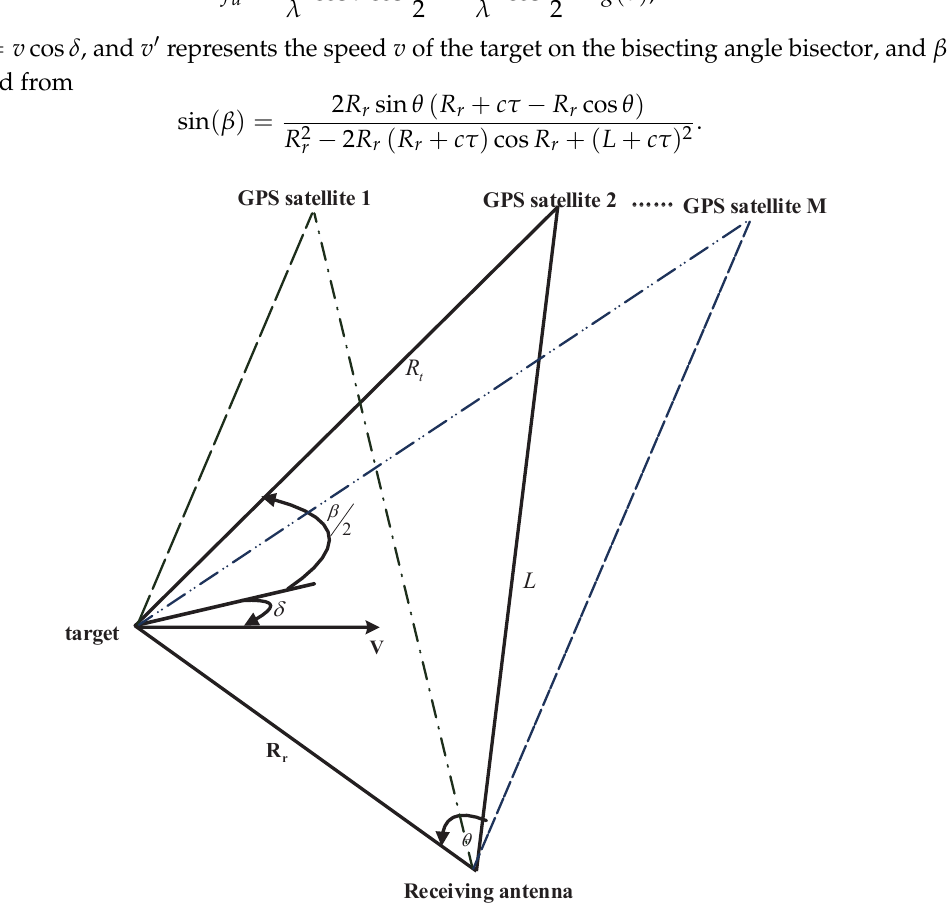
Figure 13. The geometry of the receiving